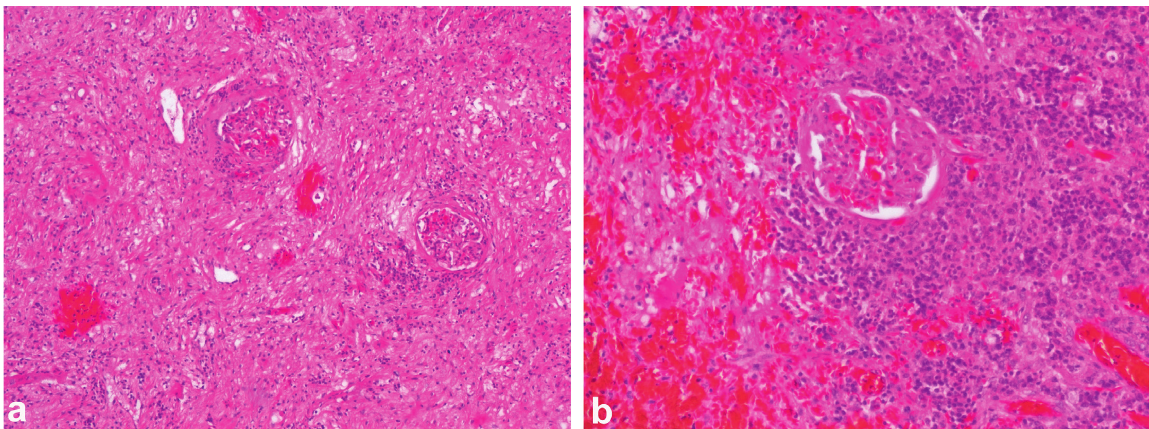
Figure 17: Histopathological section of the affected kidney showing congestion and periglomerular fibrosis, with atrophic tubules, hyaline, and RBCs casts. The interstitial tissue shows fibrosis, thick-walled blood vessels, and dense mixed inflammatory cell infiltrates. Area of necrosis with suppurative exudation is also seen (H & E, image a × 200; image b × 400) [30].